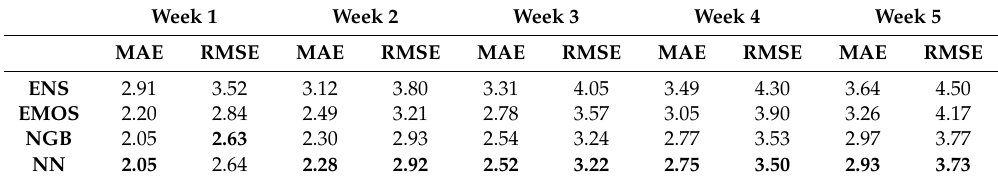
Table 1. Comparison of deterministic forecasts of the 2-m maximum air temperature over East Asia for the year 2016 at di ff erent lead times. The values representing the best performance are marked in